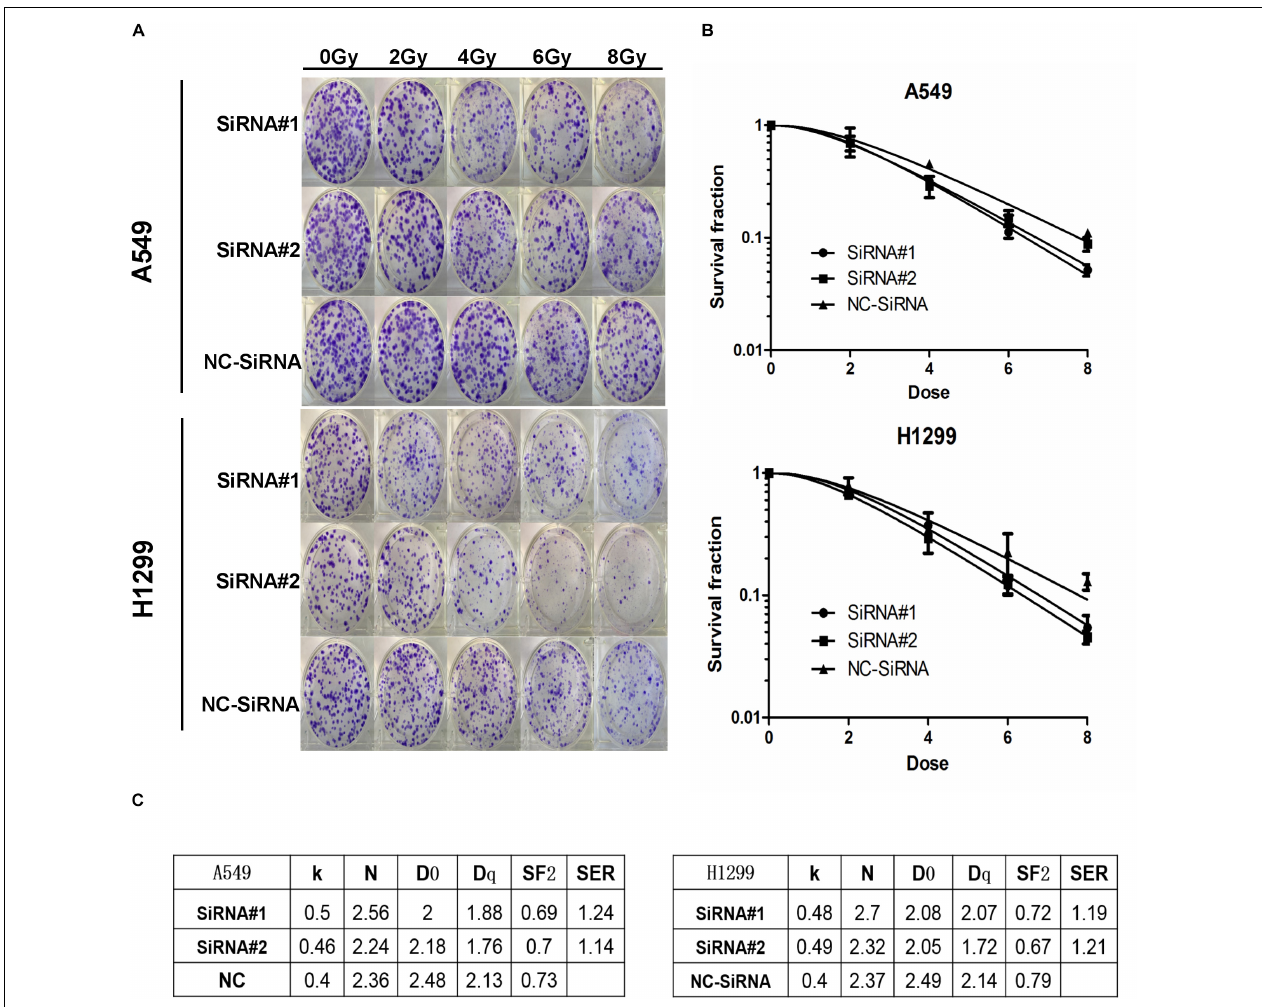
FIGURE 7 | PKMYT1 silencing results in enhanced radiosensitivity of lung adenocarcinoma cells. (A) Representative images of colony formation in A549 and H1299 cells pretreated with SiRNA#1, SiRNA#2, or NC-SiRNA for 48 h and then exposed to 2, 4, 6, or 8 Gy of X-ray irradiation. (B) Clonogenic cell survival curves were generated for A549 and H1299 cells treated with SiRNA#1, SiRNA#2, or NC-SiRNA after radiation. The survival data were normalized to those of the unirradiated control cells. (C) The single-hit multitarget model to calculate the radiobiological parameters of A549 and H1299 cell lines after downregulating PKMYT1